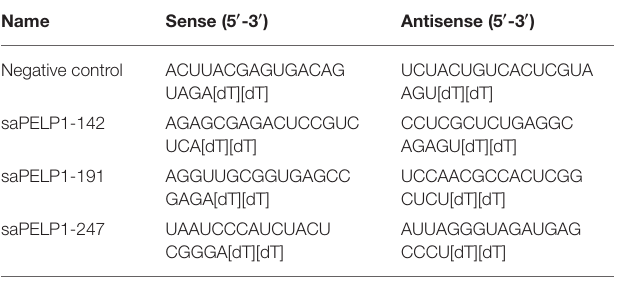
TABLE 2 | saRNA sequence. TABLE 3 | Primers for